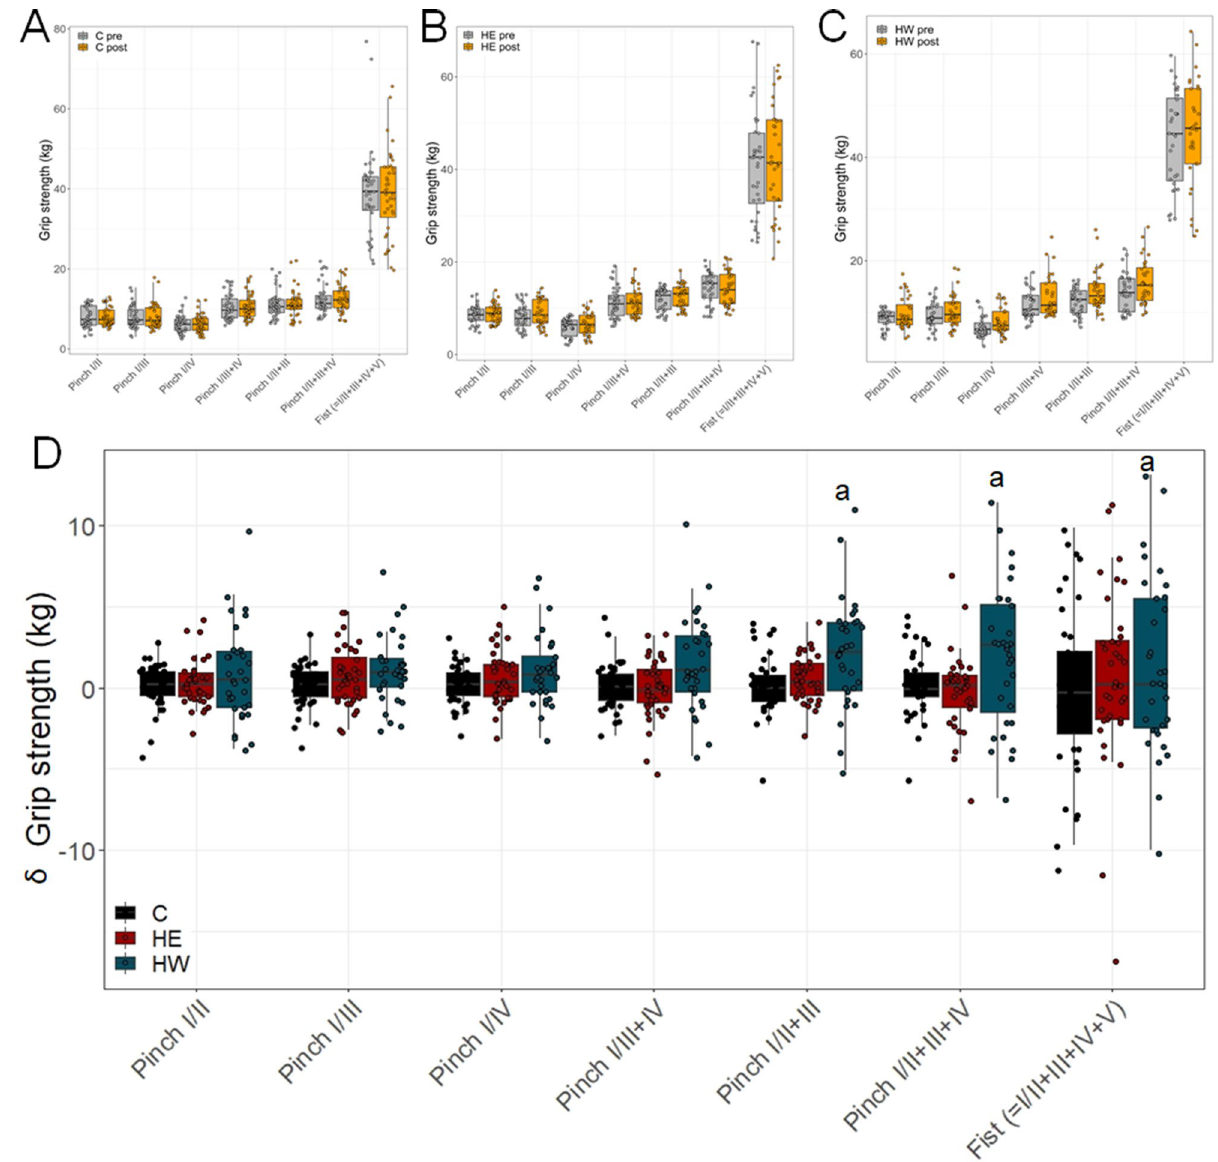
Figure 1. Grip strength post–pre training for each group individually and differences among groups. ( A ) In the C group. ( B ) HE group, and ( C ) HW group, the pairwise comparisons for each pinch are depicted. ( D ) A comparison between the groups showed that the HW group had improved pinch strength in I/II + III, I/ II + III + IV and fist (I/II + III + IV + V) compared to the control (C) group. a differed significantly from Compared to this, a smaller amount of muscles, but more specific training of these, might be needed to hold smaller edges in the HE protocol. A less resistance-focused training like HE did not improve the smaller pinches significantly (I/III, I/IV and I/II + III just insignificantly improved with small effect sizes), but the effects of HW were substantial. The fact that we tested grip strength instead of grip endurance might have missed certain effects more pronounced in the HE group, since a higher training intensity on more distal joints (distal interphalangeal joints) was created. The relatively low specificity of grip strength performance testing might also have affected the small effect sizes measured. We found that only HW improved grip strength in the athletes over time in a statistically significant man- ner. While the improvements in the HW group involved almost all grips, the HE training failed to do so in the pinches I/II, I/III + IV, I/II + III + IV and fist. Only the increases in grip strength in I/II + III, I/II + III + IV and fist, and just in the HW group, were large enough to surpass the C group significantly. Since studies comparing hangboard protocols are scarce, the studies by López-Rivera and González-Badillo 5,14 , and Medernach 15 served as the main comparators to our findings. López-Rivera and González-Badillo performed one study with nine rock climbers in which 8 weeks of hangboard training was undertaken 14 . Different from our study, magnesium carbonate was used to reduce the perspiration effect, and the participant initially held the edge